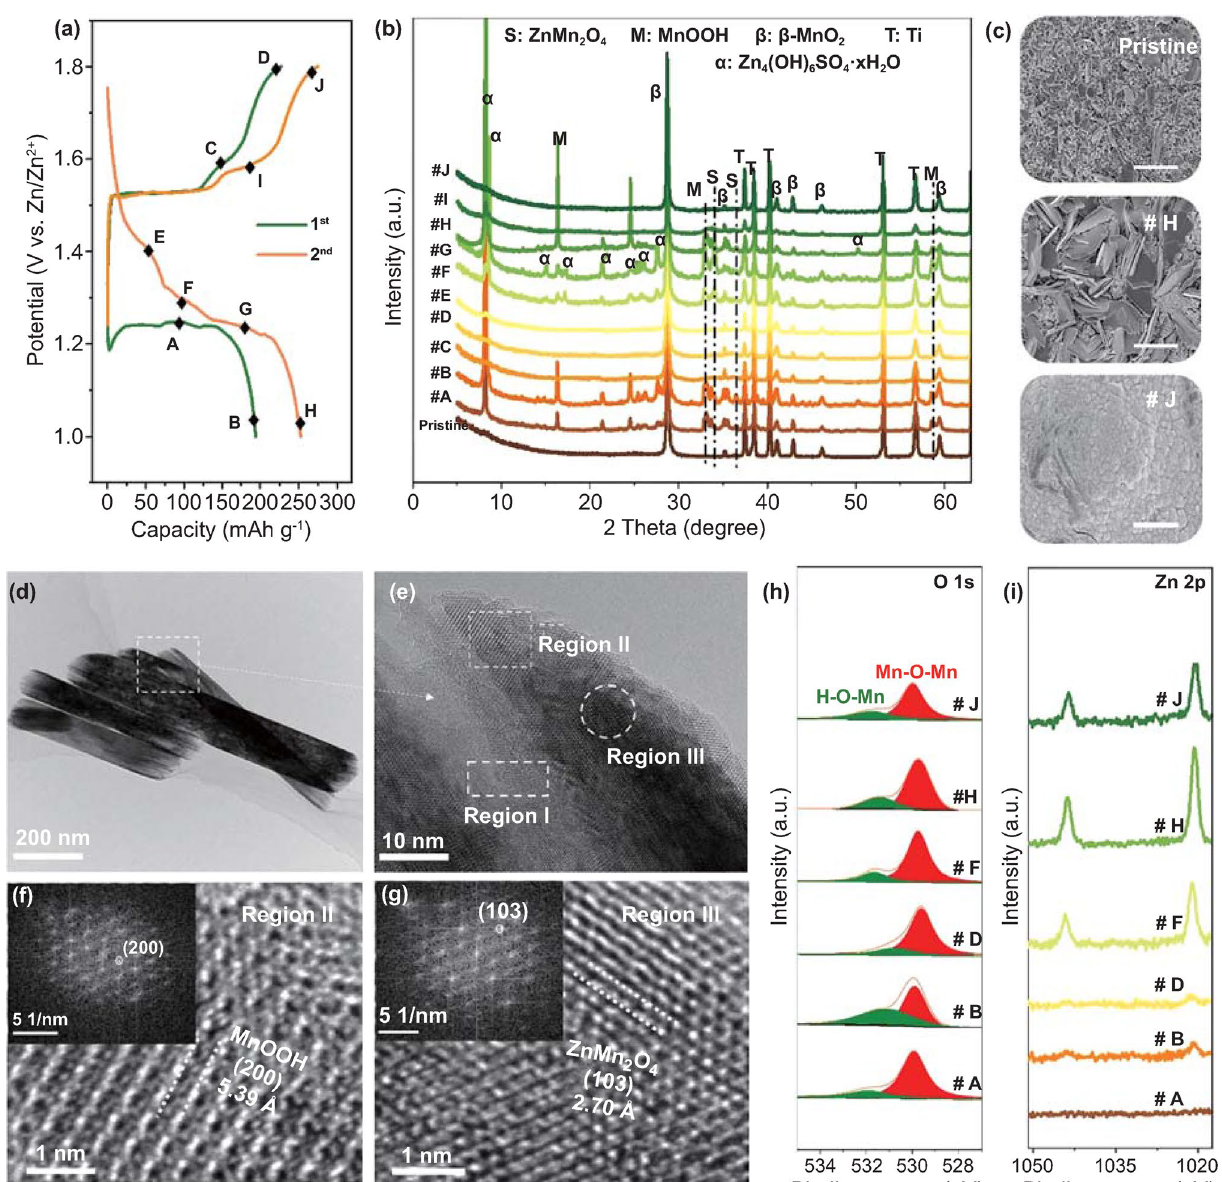
Fig. 3 a Galvanostatic charge/discharge curves at 0.1C in the initial two cycles, and b, c XRD patterns and SEM morphologies of β-MnO 2 @GO electrode at pristine, points #H and #J. d–g TEM and HRTEM images of β-MnO 2 @GO at fully discharged state in the first cycle. h, i XPS analy- ses of O 1 s and Zn 2 p spectra at selected points. Scale bars in c are ~ 2